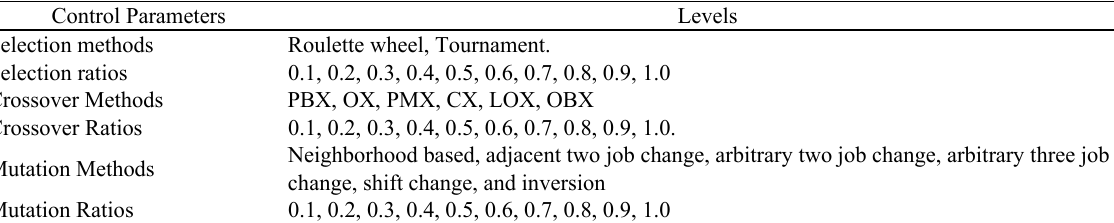
Table 2. The levels of GA control parameters Control Parameters